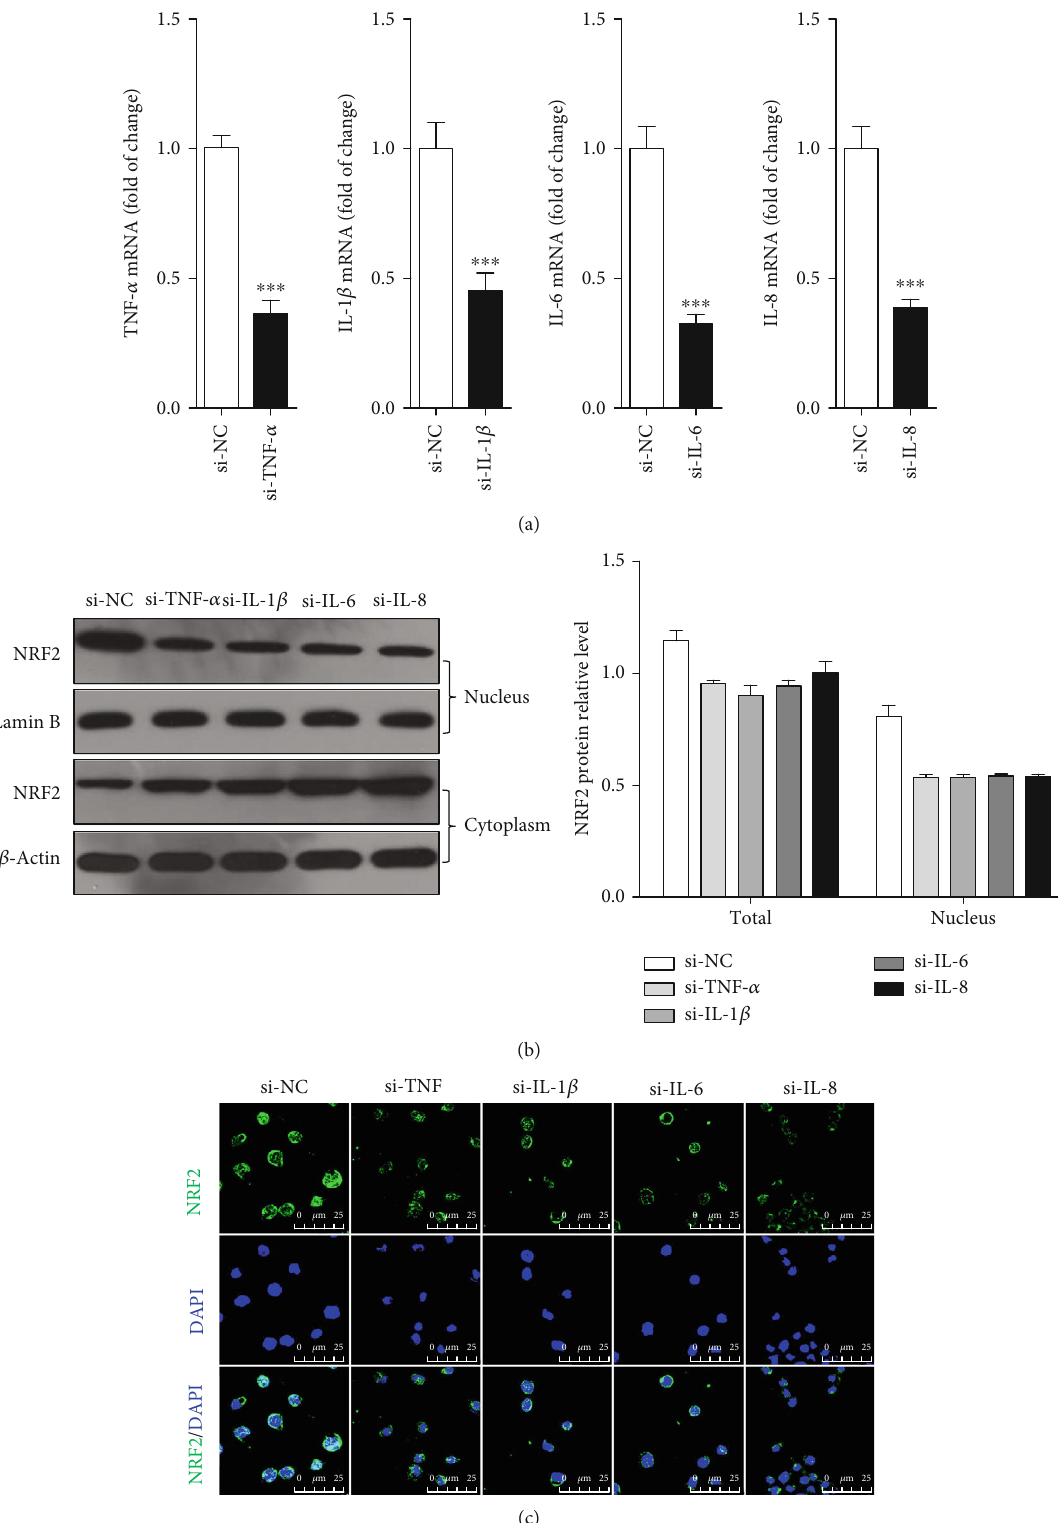
Figure 7: Depleting proin fl ammatory cytokine expression decreased LPS-induced NRF2 expression and nuclear abundance of NRF2. 72 hours after transferring si-RNA to gEECs, (a) RT-qPCR was used to detect the expression of TNF- α , IL-1 β , IL-6, and IL-8 mRNA. (b) Immunoblotting was used to detected the expression of NRF2. (c) The dynamic changes of cytoplasmic and nuclear NRF2 were imaged by immuno fl uorensent staining. ∗∗∗ was P < 0 : 001 vs. si-NC group, and P value was calculated by the one-way ANOVA with Tukey ’ s test as a posthoc test. Scale bar was 45 μ